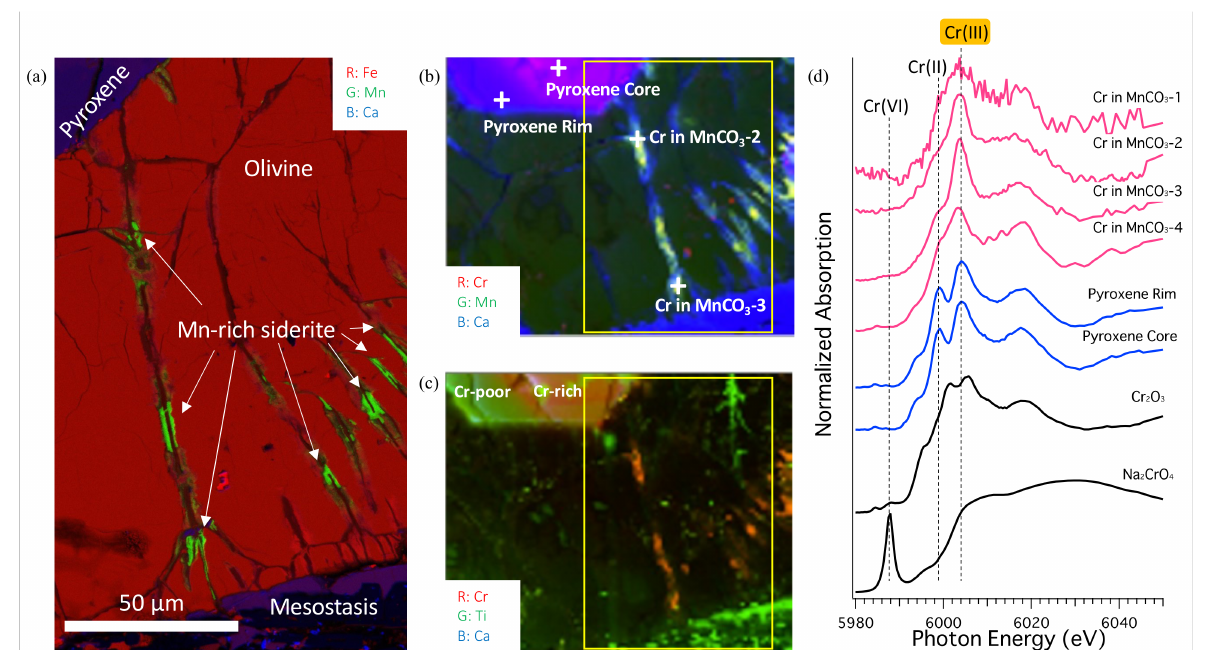
Figure 7. µ -XRF-XAFS analysis results focusing on Mn and Cr in Mn-rich siderite. ( a ) RGB composite image of representative olivine containing carbonate iddingsite by EPMA. Red, green, and blue colors indicate Fe, Mn, and Ca, respectively. The heterogeneous greenish area indicates Mn-rich siderite (MnFeCO 3 ). ( b ) RGB elemental image of the same area shown in ( a ) by µ -XRF-XAFS. Red, green, and blue colors indicate Cr, Mn, and Ca, respectively. The yellow part is Mn-carbonate, which clearly contains Cr in the Mn-bearing carbonate. ( c ) Red, green, and blue colors indicate the distributions of Cr, Ti, and Ca, respectively. Ca is also found in the iddingsite. The yellow square indicates the view of ( a ). ( d ) Representative Cr K-edge XANES spectra obtained from the Mn-rich siderite carbonate in the portion marked by “+” in ( b ) and in Figures S4c and S4e. The XANES spectrum of the yellow part shows peak energy similar to that of Cr 2 O 3 , which suggests that the Cr is Cr(III) in the Mn-rich